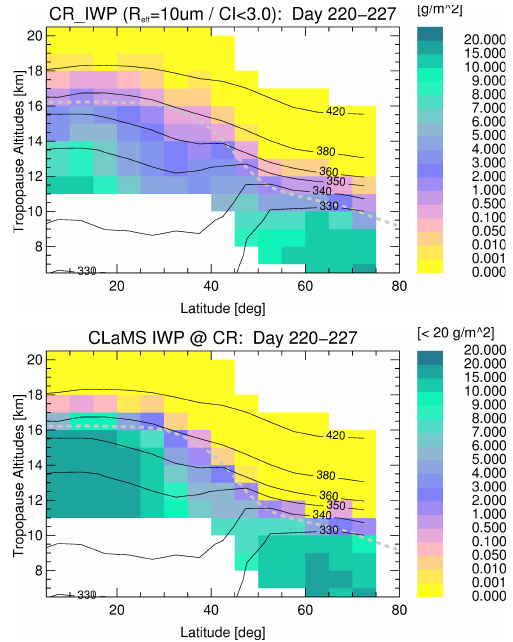
Figure 10. Zonal mean CRISTA limb IWP retrieved from CI (top) and from the CLaMS model (bottom) with a shortcut of IWP CLAMS >20gm − 2 at the upper detection sensitivity of CRISTA (right). For the computation of IWP CR , it is necessary to assume a constant effective radius for the ice particles ( R eff =10µm is applied, see also Eq.